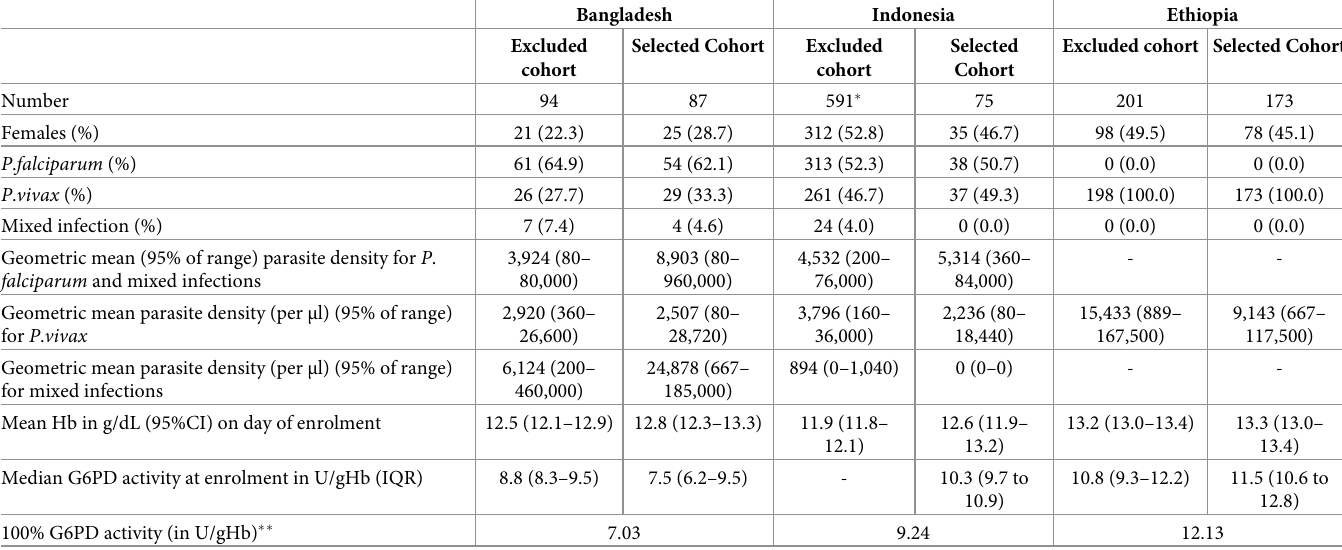
Table 1. Characteristics of selected and non-selected participants per study site.